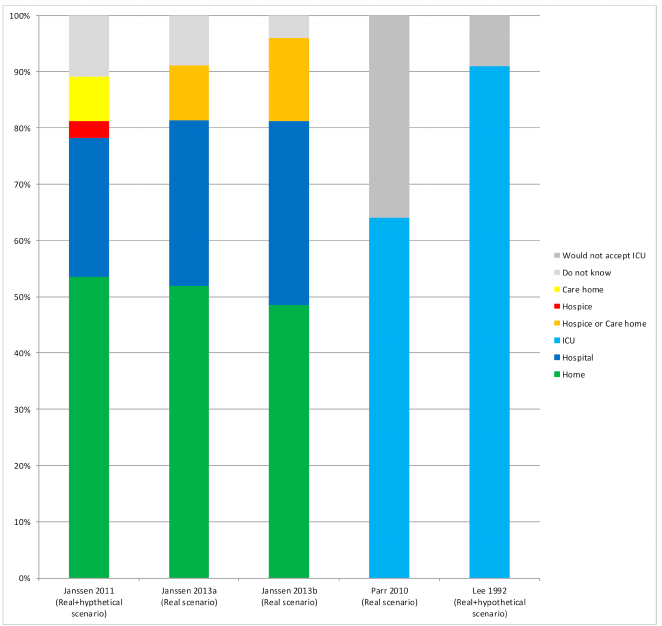
Figure 6. Preferences regarding place of end-of-life care: Shows results (%) from studies that assessed preferences regarding the place of end-of-life care.Two studies [38,45] assessed patients’ preferences for ICUs as a place to receive EoL care (Figure 6). Thirty-six percent of patients with advanced cancer and a life expectancy of less than six months were against dying in an ICU [45], compared with 91% of older adults with multimorbidity but a life expectancy over six months, who considered dying in an ICU to be a ‘bad death’